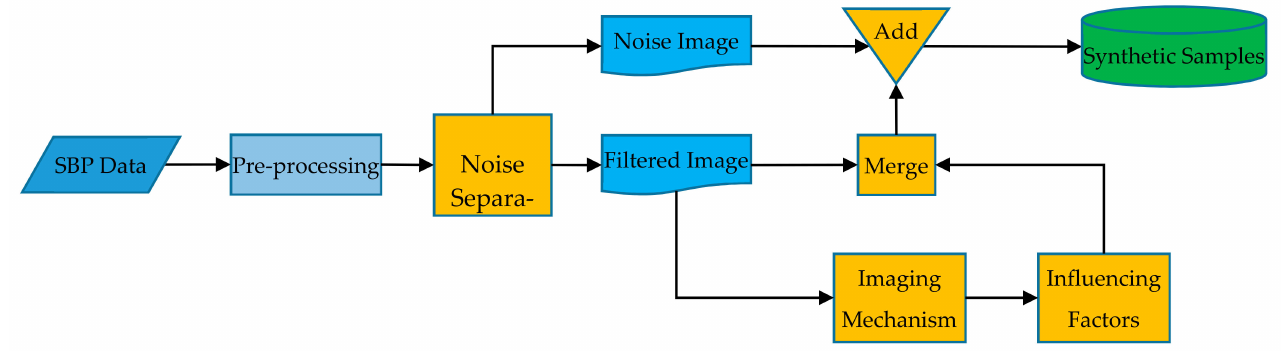
Figure 7. Pipeline sample synthesis flow